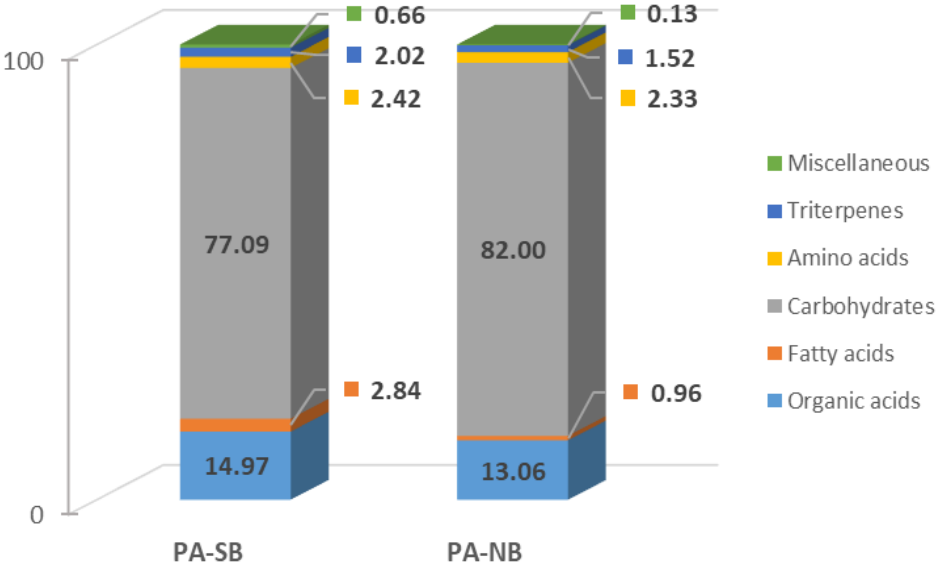
Figure 2. Distribution of compounds (GC-MS) in dry ethanolic extracts from Physalis alkekengi fruit: PA-SB—fruit from Central Southern Bulgaria; PA-NB—fruit from North-eastern Bulgaria.